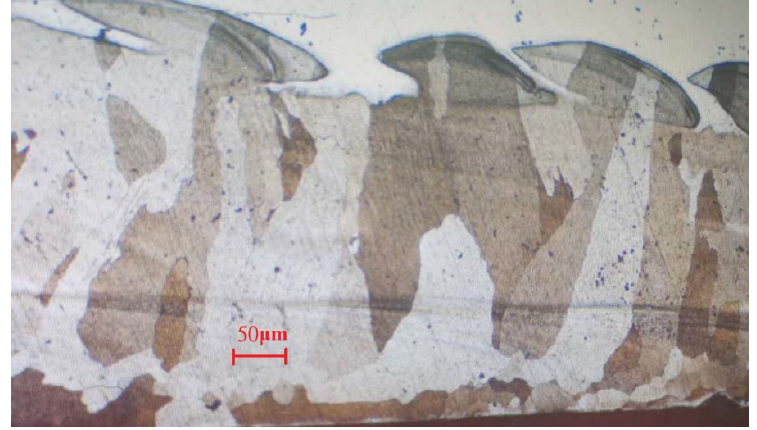
Figure 11. Microscopic metallographic analysis of the welded plate with upgraded parameters.